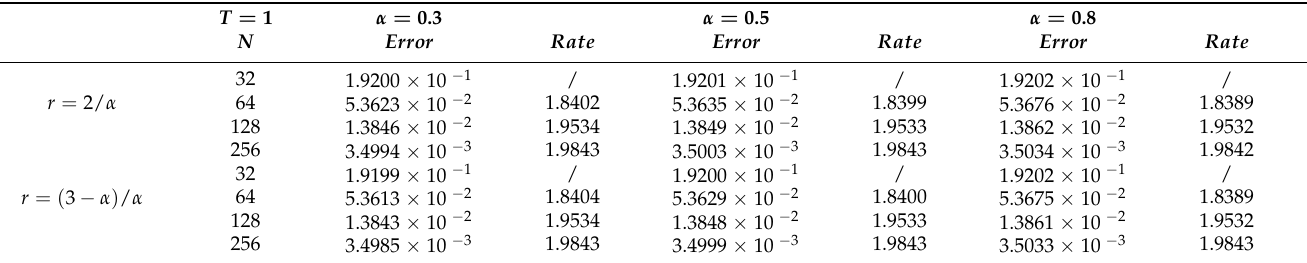
Table 9. Temporal numerical results of (cid:107) I 2 h U n − u n (cid:107) 1 on graded meshes to Example 2.